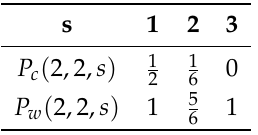
Table 1. Values of P c ( 2,2, s ) and P w ( 2,2, s ) for s ≥ 1.